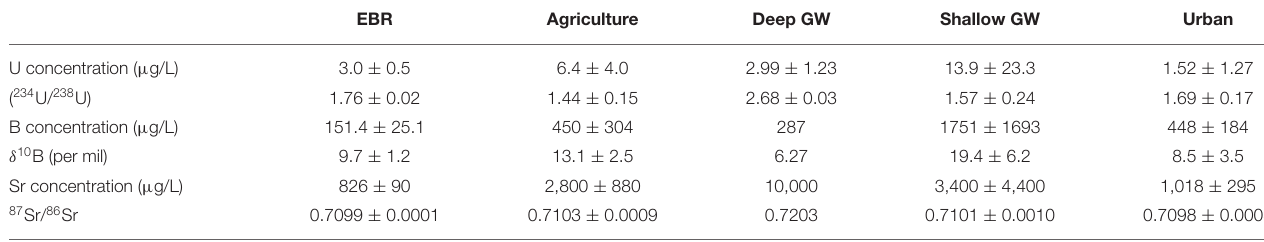
TABLE 1 | End member values inferred for salinity sources in the Rio Grande Watershed in this